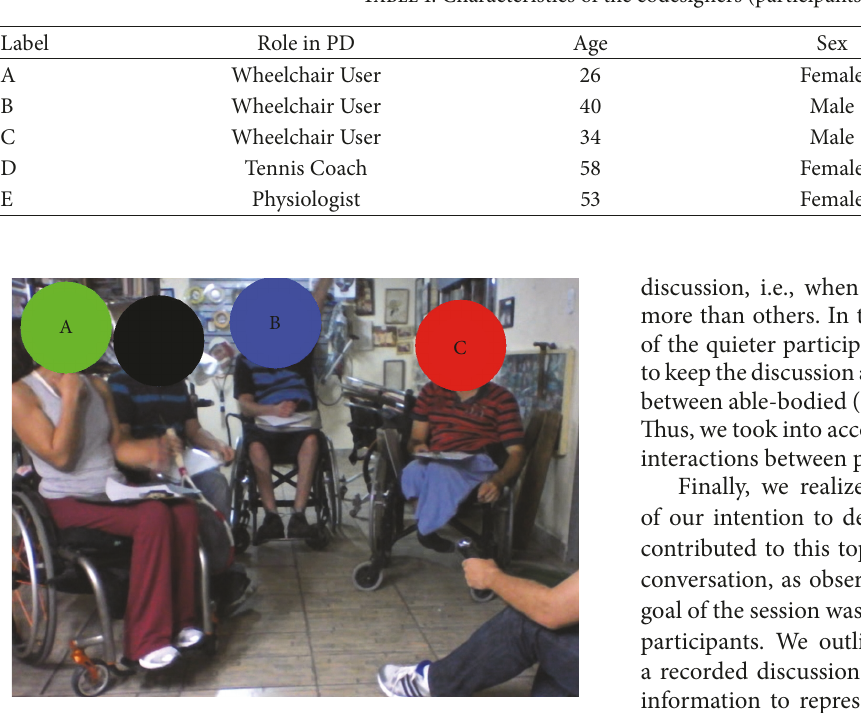
Figure 1: Participants A, B, and C during the first PD session: they used paper and pencil to annotate their